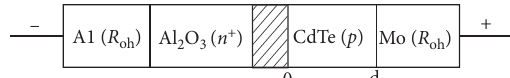
2 O 3 - p -CdTe-Mo